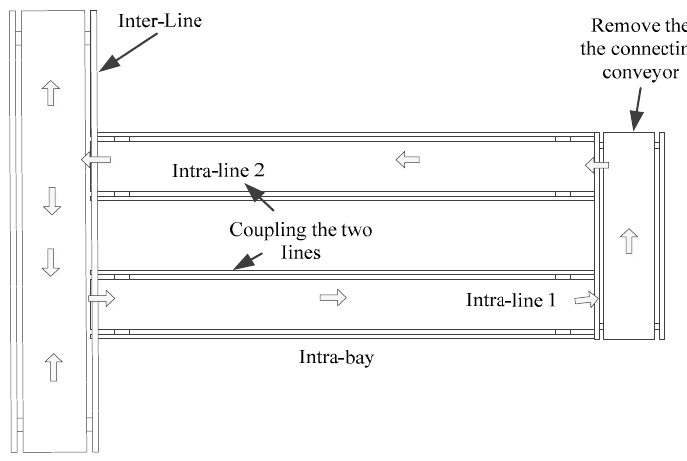
Figure 4. Couple Intra-Line 1 and Intra-Line 2 in an Intra-bay.